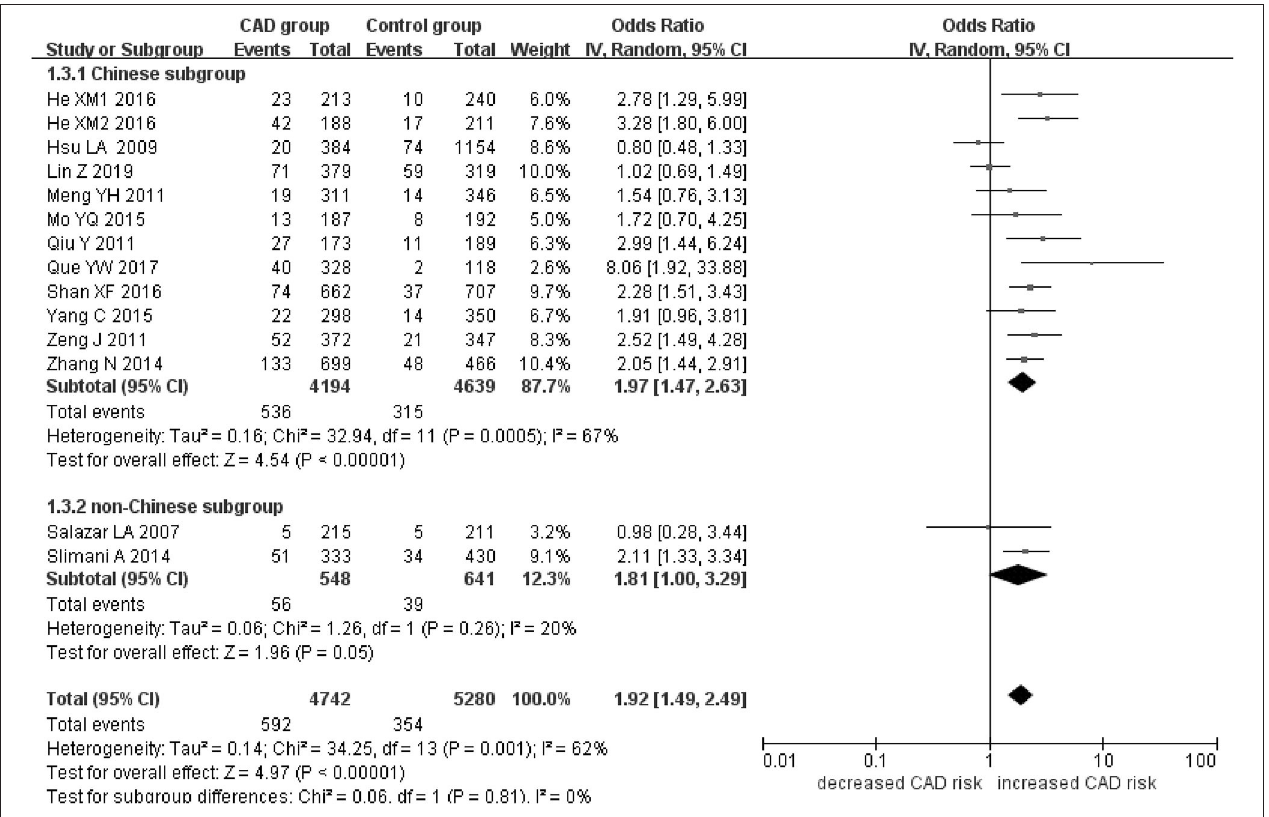
FIGURE 4 | Forest plot of CAD associated with PCSK9 gene E670G polymorphism under an additive genetic model (total G allele vs. total A).